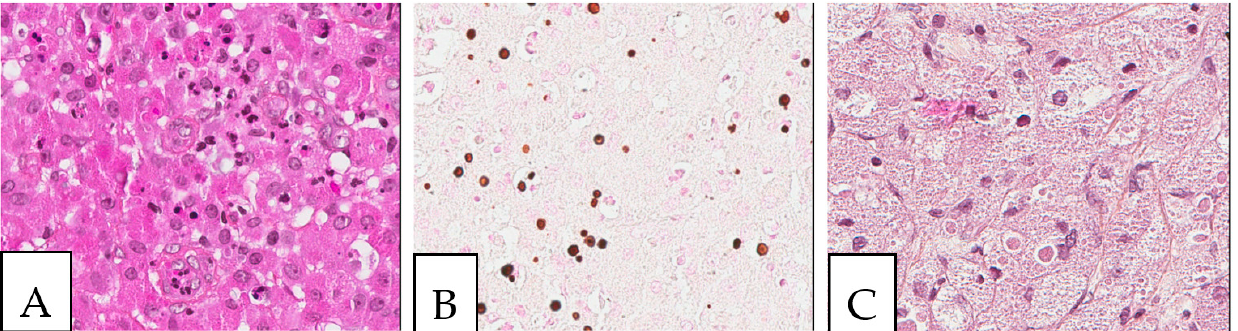
Figure 3. Malakoplakia. ( A ). Malakoplakia is an inflammatory process consisting of macrophages with an abundant eosinophilic cytoplasm (hematoxylin, eosin, Safran). The lesion was found in a 60-year-old male patient who underwent a colonoscopy within the context of pre-renal transplant evaluation and was found to have this lesion as a perianal polyp that was removed by polypectomy. ( B ). The characteristic Michaelis–Gutmann basophilic inclusions are better highlighted by the Von Kossa stain. ( C ). Granular cell tumor with microgranular eosinophilic cytoplasm containing the pustule-ovoid bodies of Milian (eosinophilic globules surrounded by a clear halo). This lesion presented as a reddish skin nodule in a 48-year-old-female patient.